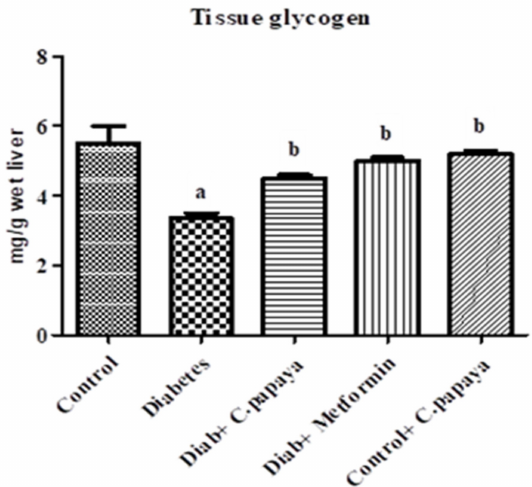
Figure 5. This figure Represents the outcome of the ethanolic extract of C. papaya on tissue glycogen contents in the control and diabetic rats. Each bar indicates the mean ± SEM of eight rats, with p < 0.05 indicating significant differences between the groups as: a—control and b—diabetes.